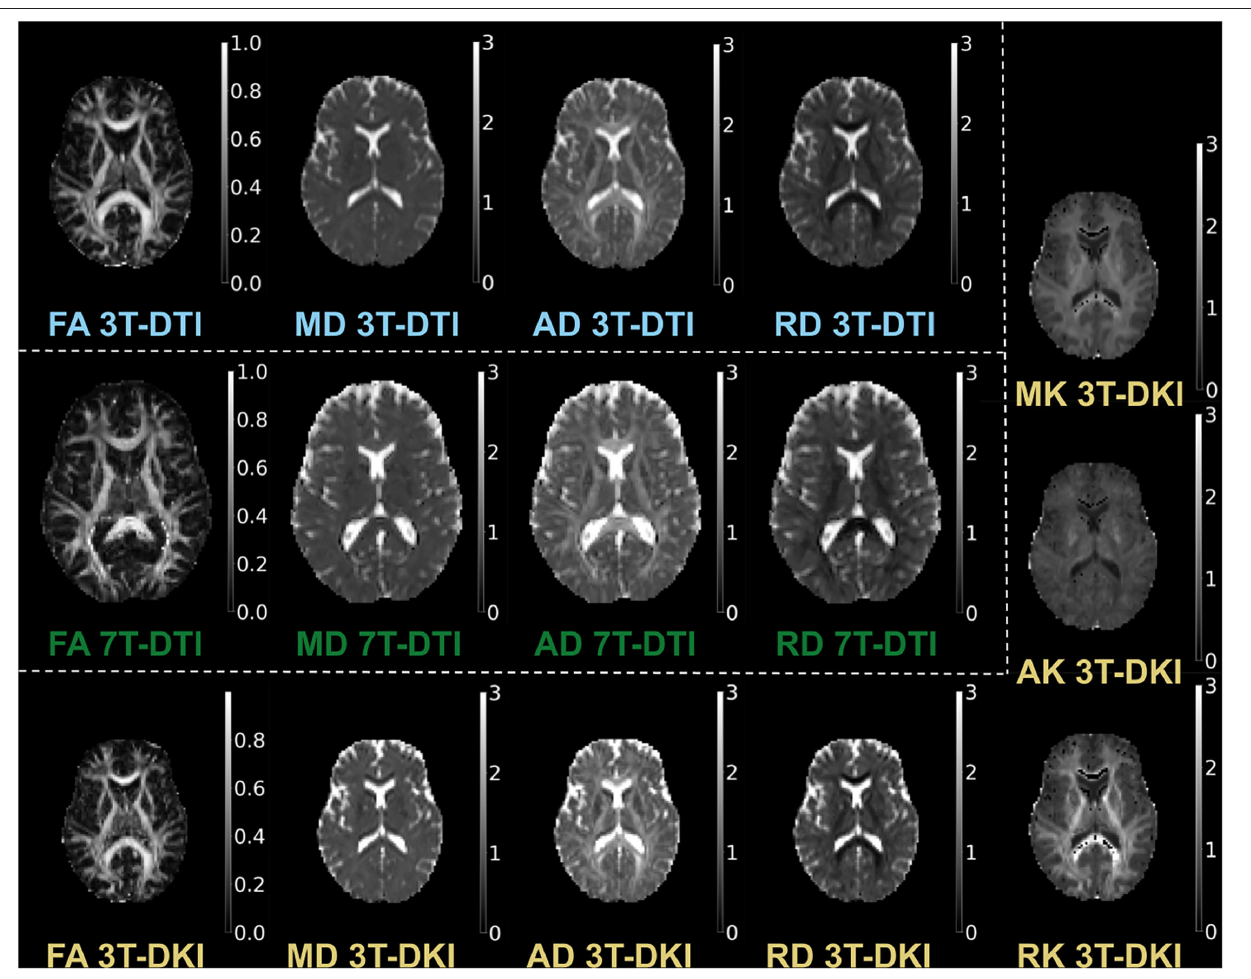
FIGURE 2 | Examples of parameter maps. The maps derived by 3T-DTI are labelled in cyan, the ones derived by 7T-DTI in green, and the ones derived by 3T-DKI in gold